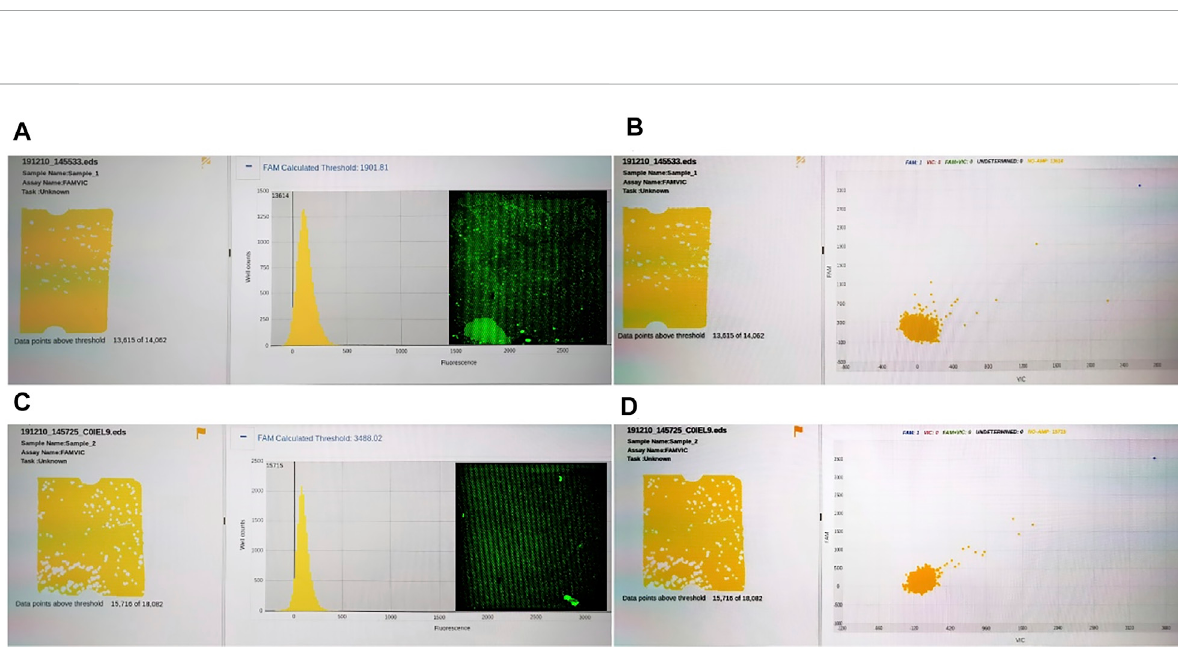
FIGURE 6 (A) Fluorescence intensity distribution of HBV DNA; (B) Fluorescence intensity distribution of HBV DNA; (C) Fluorescence intensity distribution of UPE DNA; (D) Fluorescence intensity distribution of UPE